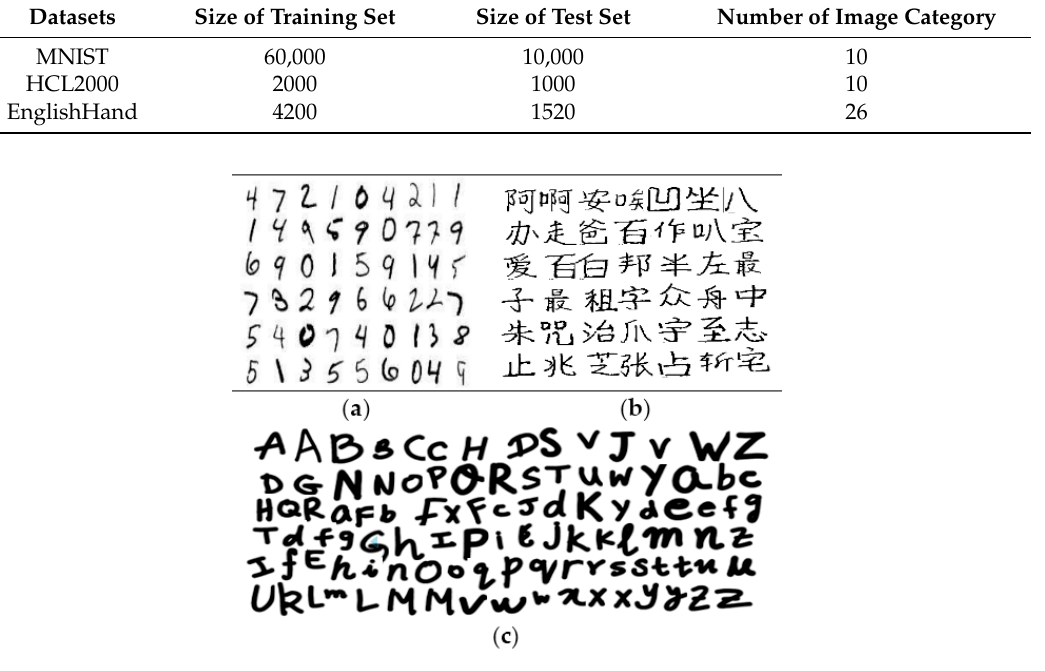
Figure 7. Sample of handwriting character images. ( a ) MNIST dataset; ( b ) HCL2000 dataset; ( c ) EnglishHand dataset.